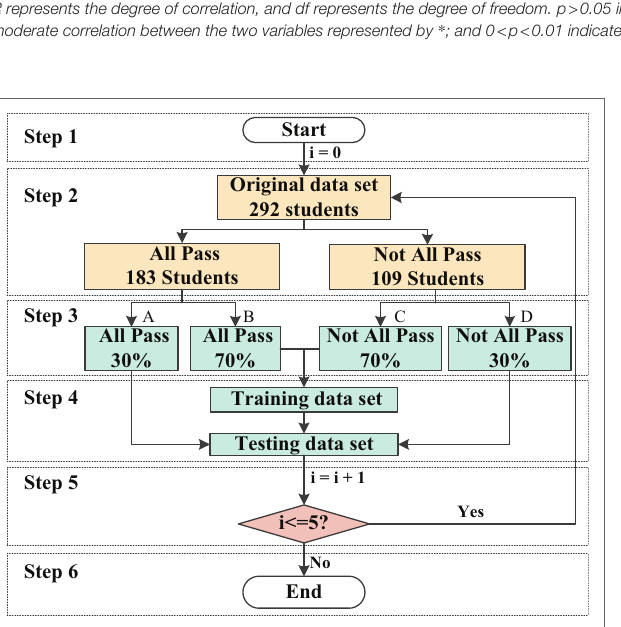
FIGURE 2 | The flow chart of dataset